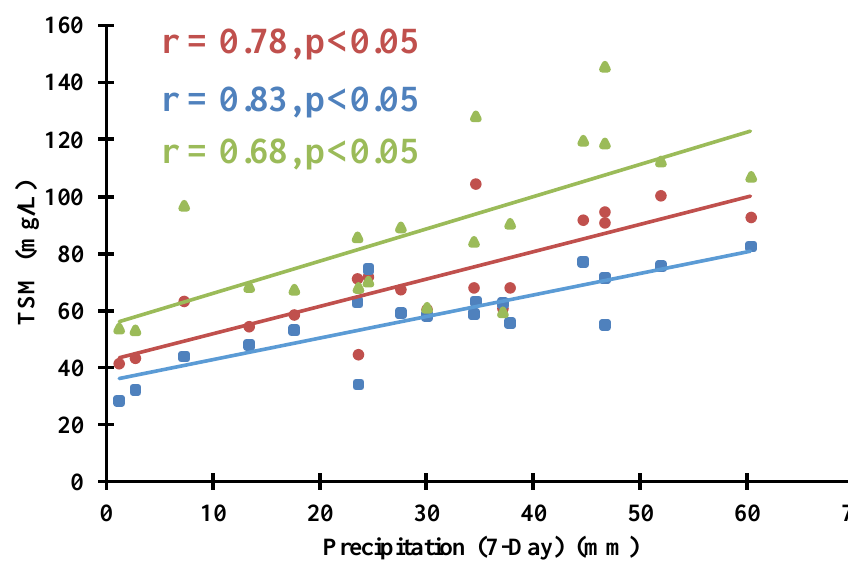
Figure 9. Relationship between precipitation data and mean TSM, 1978–2013. Precipitation data refers to total precipitation over seven days prior to the acquisition date of each Landsat image, measured at Yueyang meteorological station. Results show a statistically significant positive correlation for WDL, EDL and